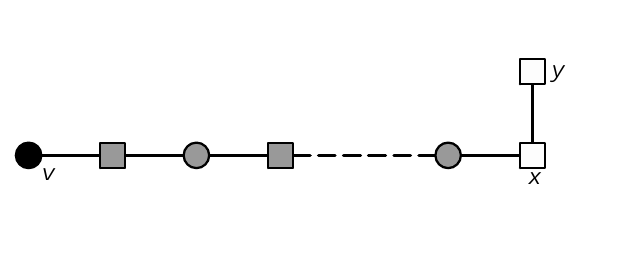
Fig. 7: Diagram showing part of the trunk R (cid:48) . Squares denote vertices of degree at least 4 and circles denote vertices of degree exactly 2.